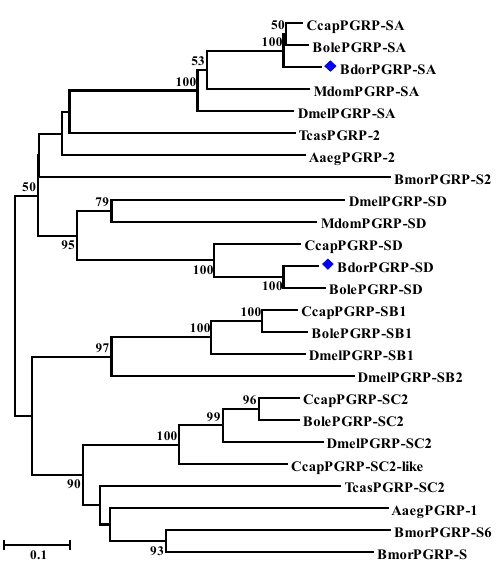
Figure 2. Phylogenetic analysis of the insect PGRPs. MEGA 5 was used to construct the phylogenetic tree using the neighbor-joining method with 1000 bootstrap replicates. All of the homologous PGRPs were retrieved from the NCBI. Insect species include Drosophila melanogaster (Dmel), Aedes aegypti (Aaeg), Bactrocera oleae (Bole), Ceratitis capitata (Ccap), Musca domestica (Mdom), and Tribolium castaneum (Tcas). Table S2 shows the amino acid sequences of the PGRPs used in the phylogenetic tree.